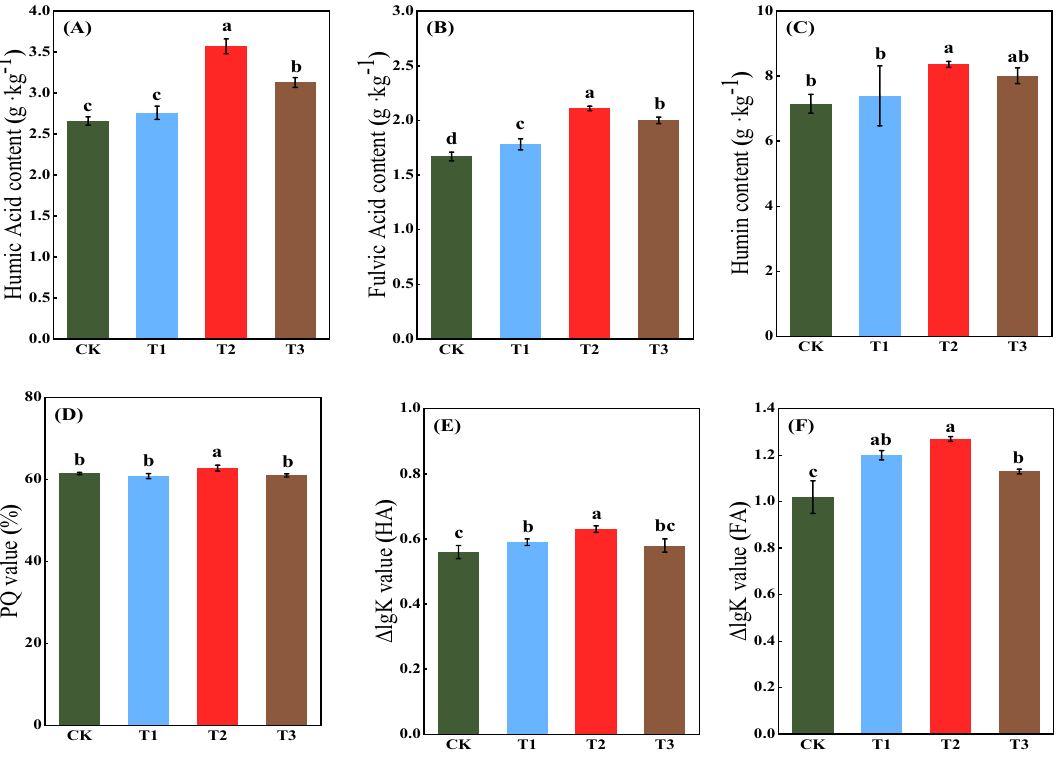
Figure 2. Effect of different treatments on humic acid content (A) , fulvic acid content (B) , humin content (C) , PQ value (D) , ΔlgK value (HA) (E) and ΔlgK value (FA) (F) . Different letters indicate significant differences at P < 0.05 (according to Duncan’s multiple range